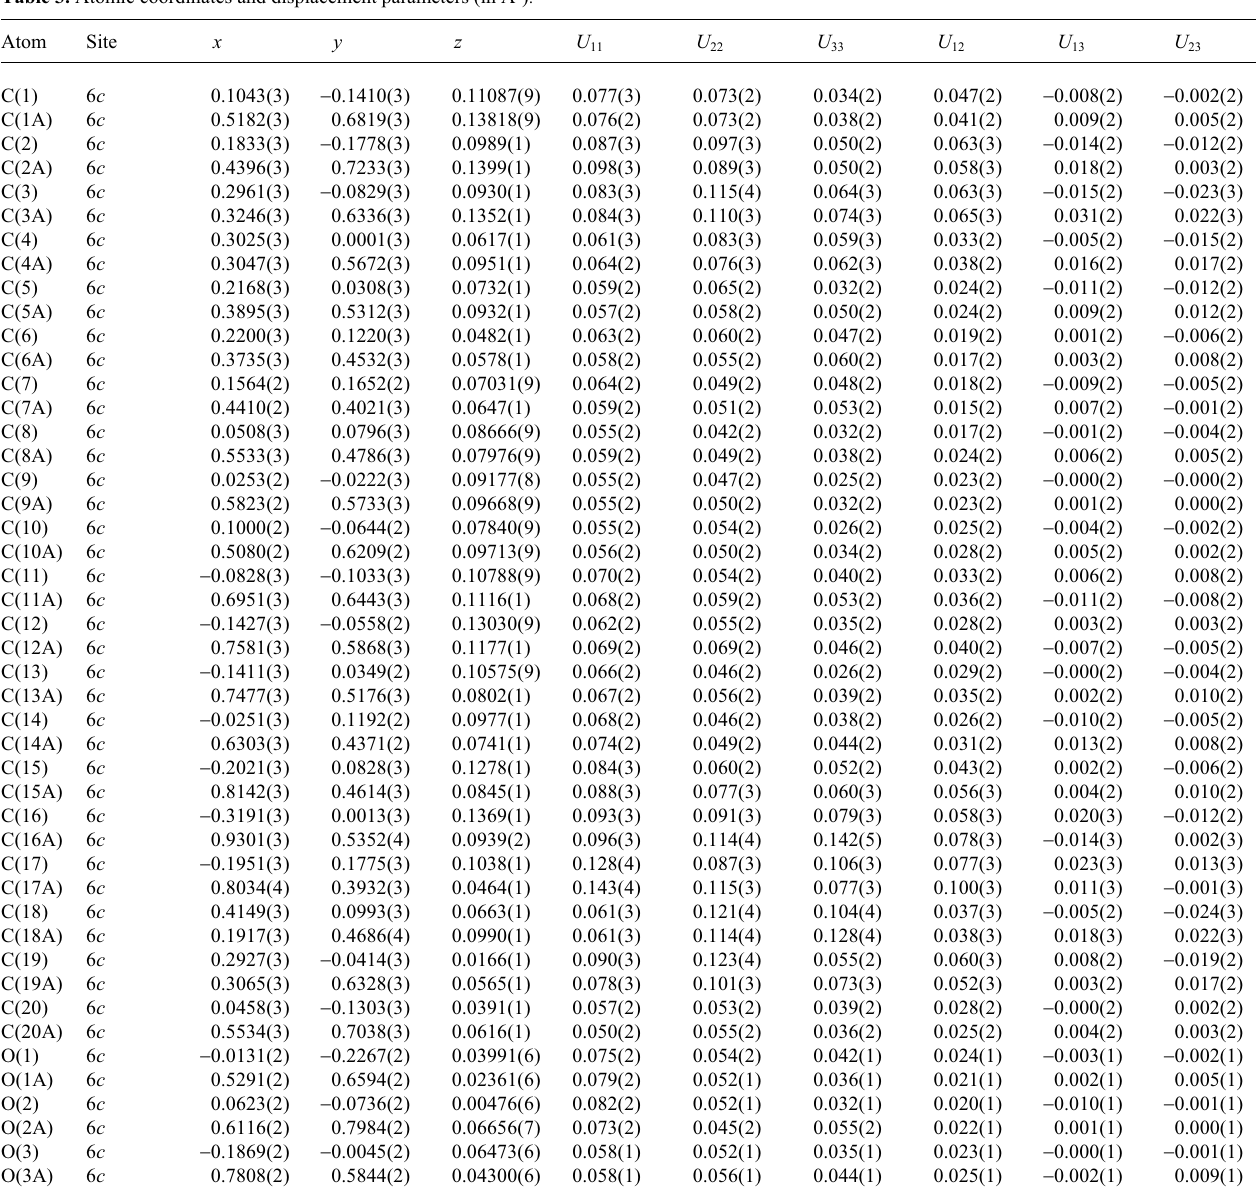
Table 3. Atomic coordinates and displacement parameters (in Å 2 ) .